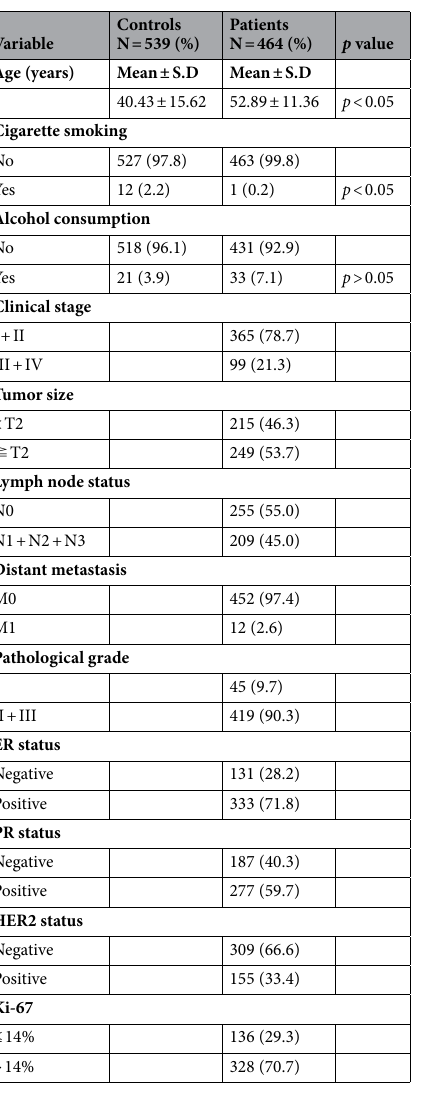
Table 1. Demographic and clinicopathological characteristics of healthy controls and patients with malignant breast neoplasms. The Mann–Whitney U test or Fisher’s exact test was used to compare values between controls and patients with breast cancer. ER, estrogen receptor; PR, progesterone receptor; HER2, human epidermal growth factor receptor 2. Pathological grade: I, well differentiated; II, moderately differentiated; III, poorly